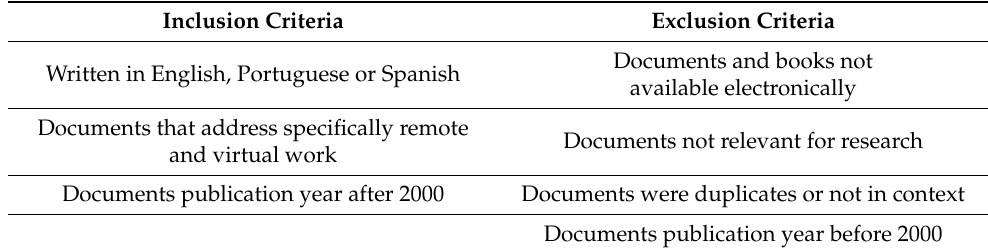
Table 3. Inclusion and exclusion criteria were applied in the performed SLR